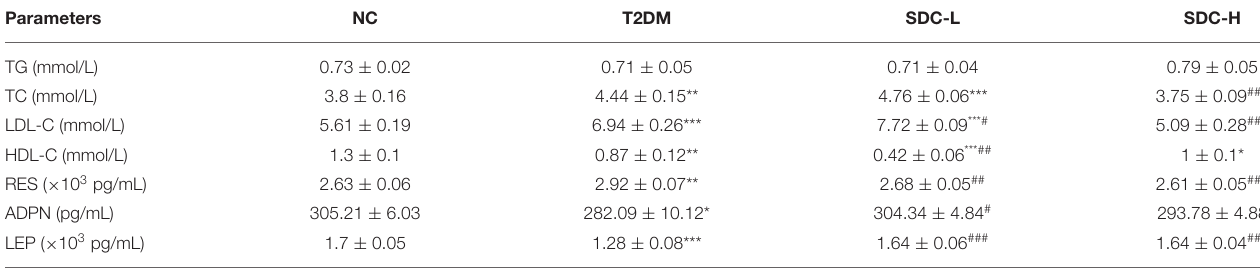
TABLE 4 | Effect of SDC on serum lipid parameters and adipokines.